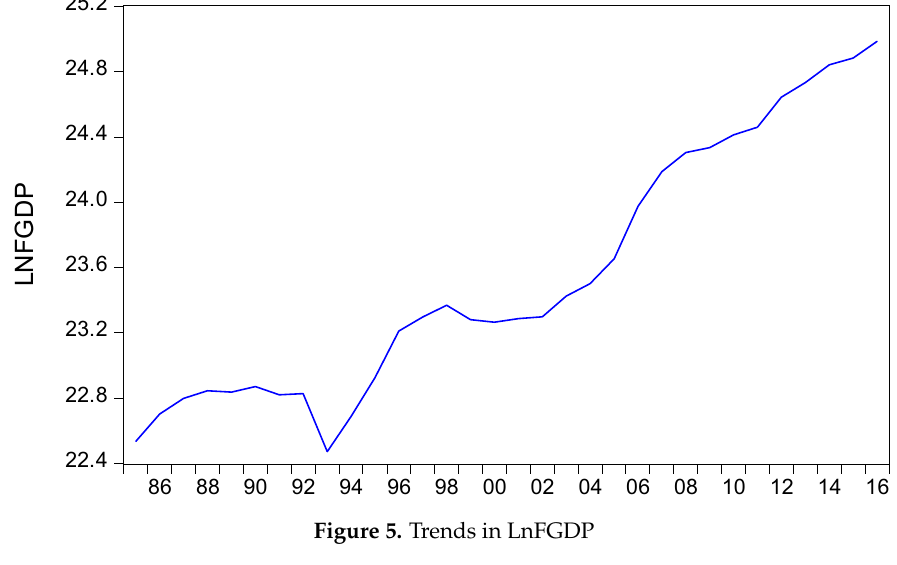
Figure 5. Trends in LnFGDP